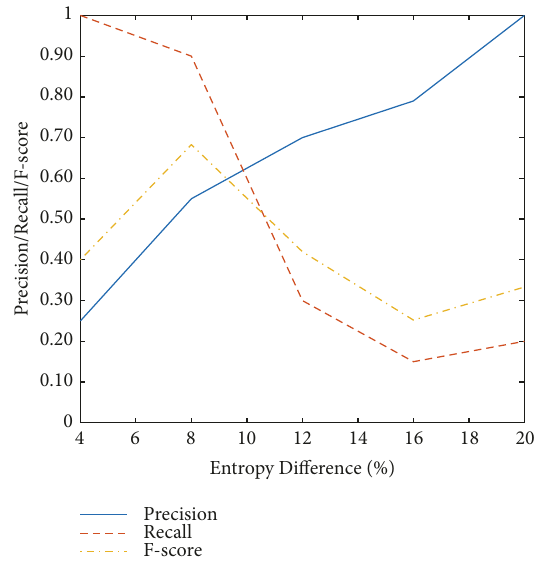
Figure 2: Sensitivity of 𝜏 𝐴 on movie Pink Panther